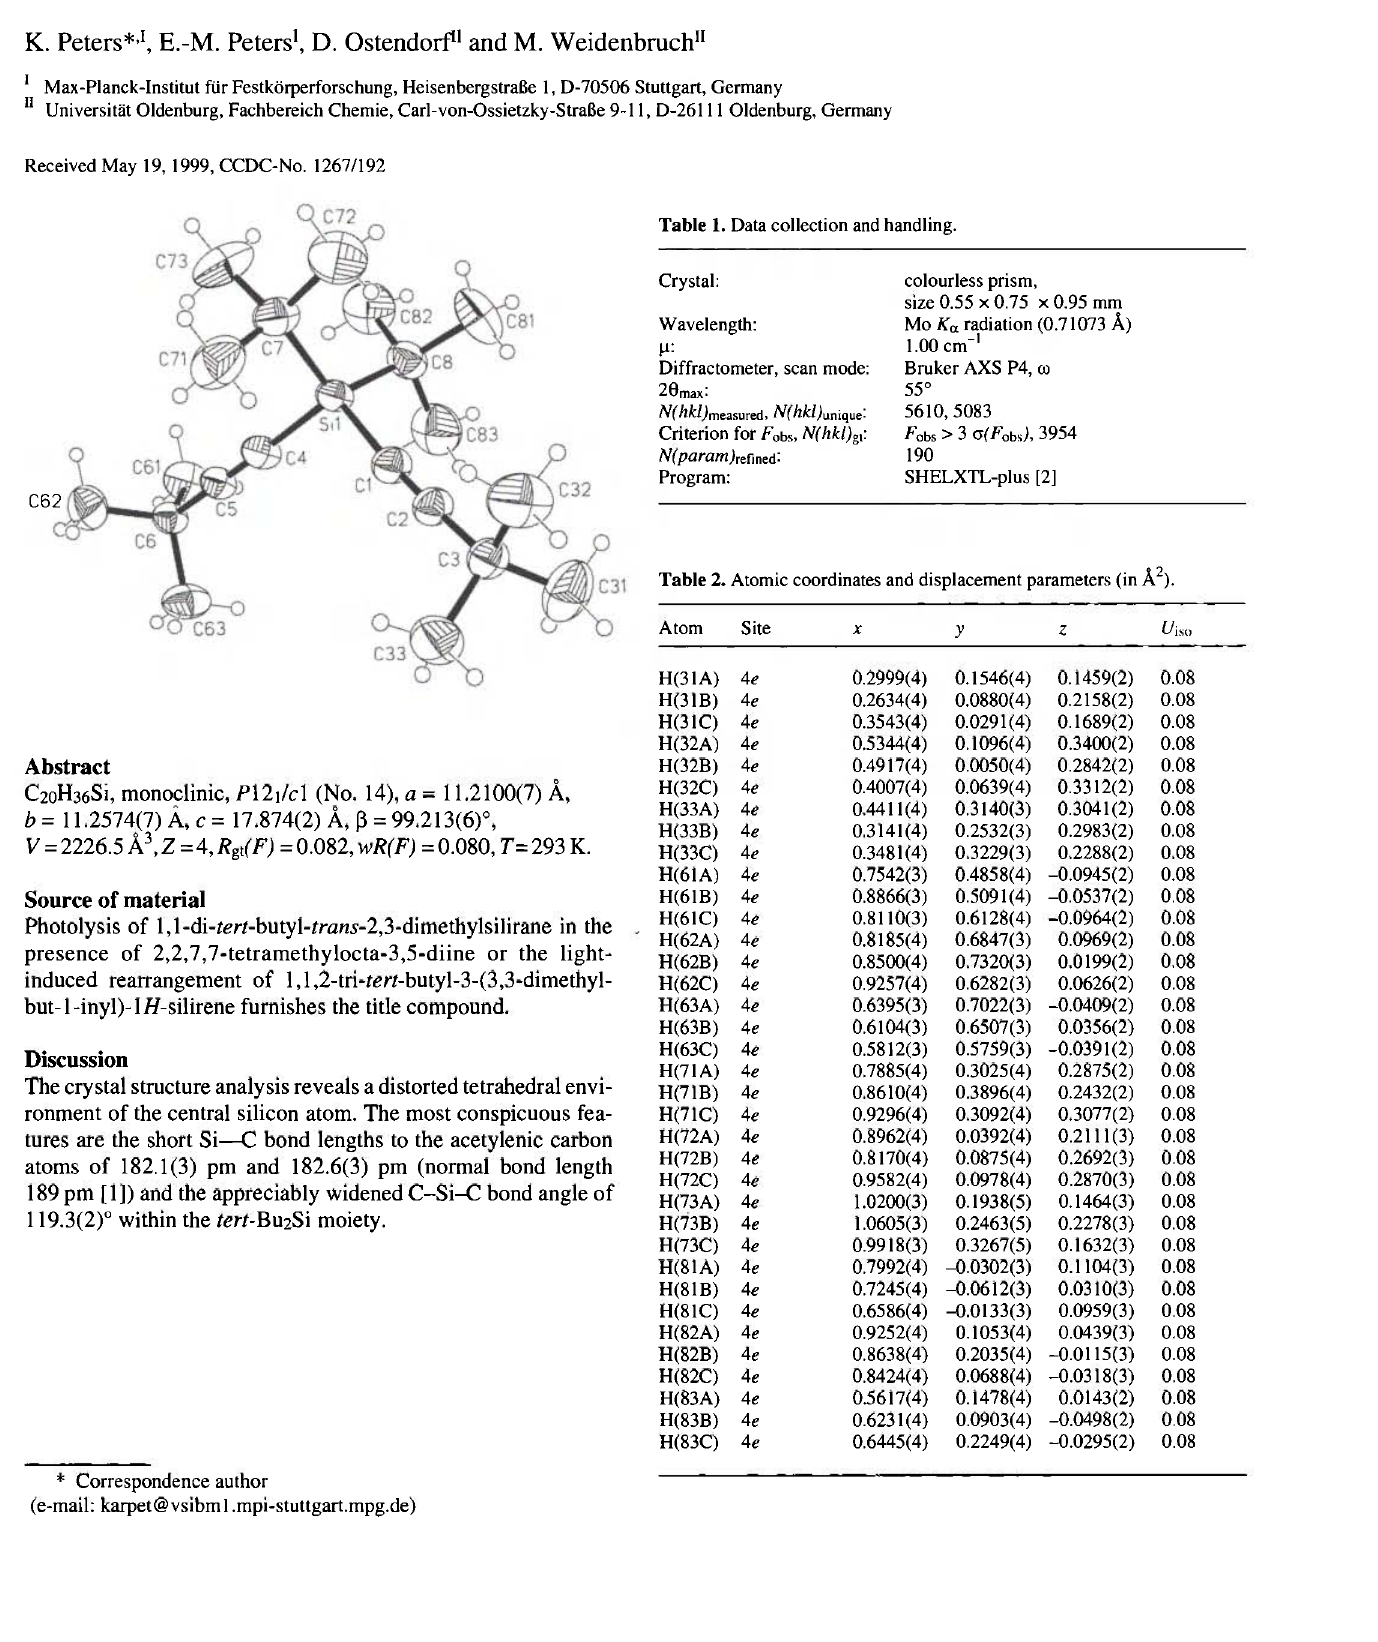
Table 1. Data collection and handling.